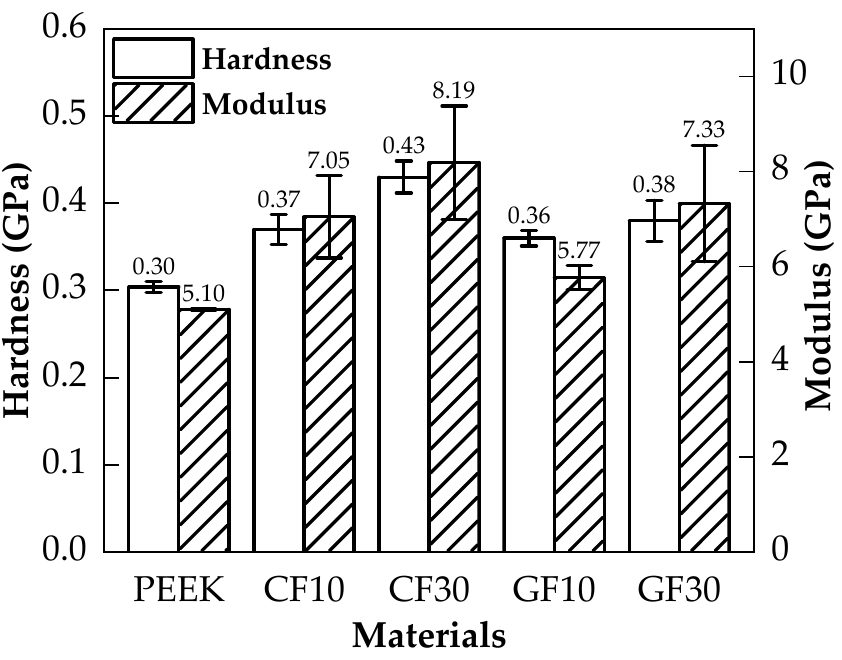
Figure 3. The average hardness and modulus of the pure PEEK and fiber-reinforced PEEK materials. Table 2. The average hardness and modulus of the pure PEEK and carbon/glass fiber. Sample PEEK Carbon